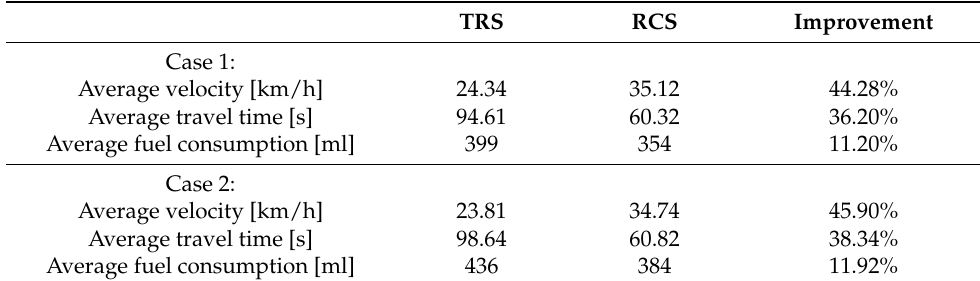
Figure 8. Average fuel consumption of vehicles, Case 1 with balanced traffic flow ( left ) and Case 2 with unbalanced traffic flow ( right ). Table 1. Performance comparison between RCS and